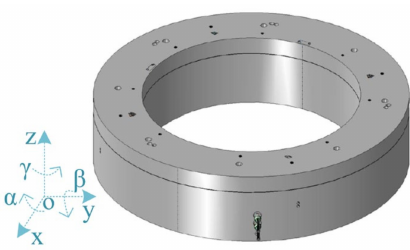
Figure 5. The 3D model of the customized piezo-driven hexapod.